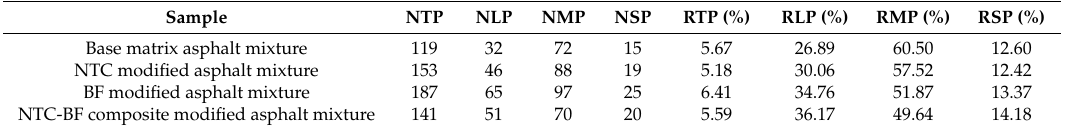
Table 4. The porosity of test asphalt mixtures.